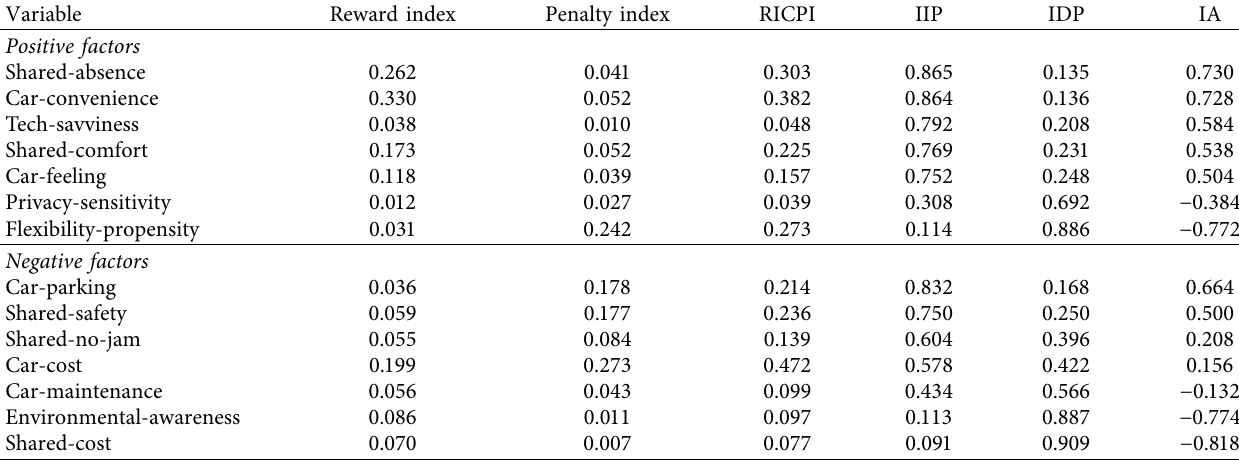
Table 6: The IA indexes of attitudinal factors influencing the post-COVID-19 intention change.